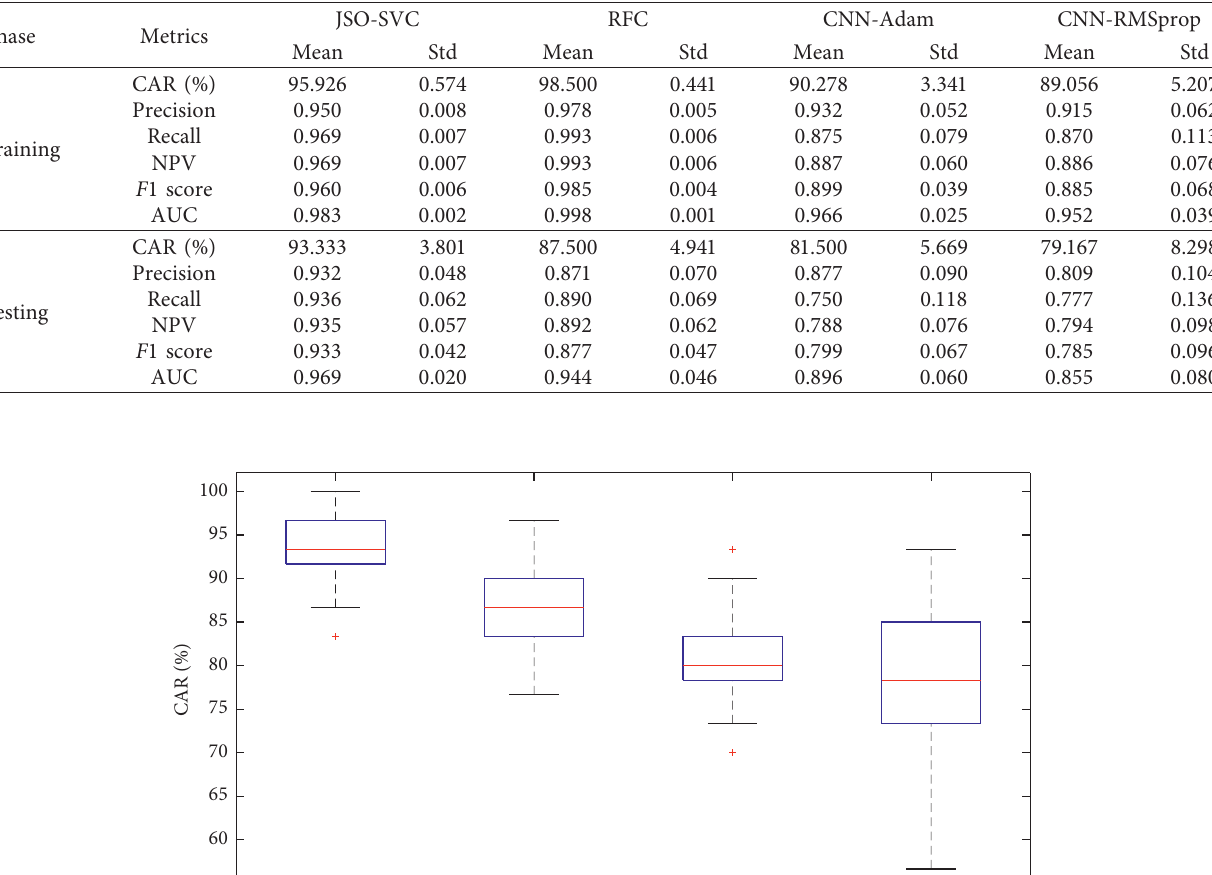
Table 2: Experimental result comparison.